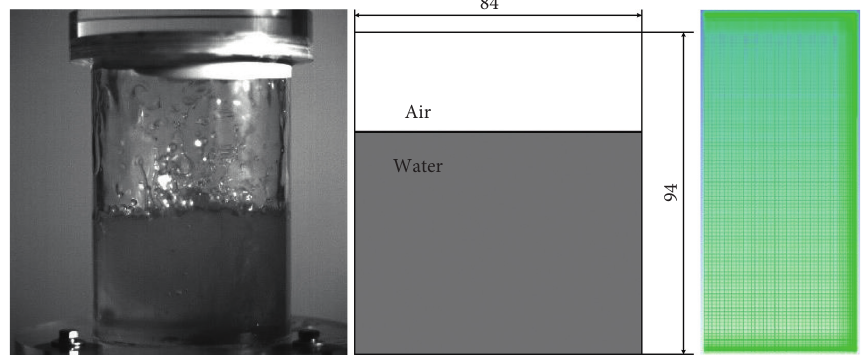
Figure 1: Real products, diagram of the vessel, and meshes of computational domain, respectively.